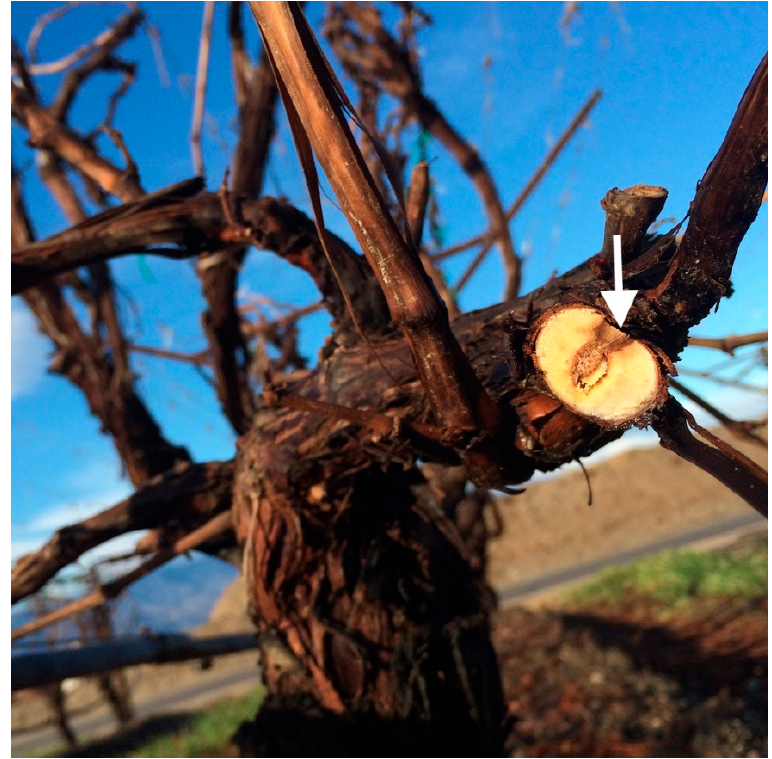
Figure 3. Trunk Diseases symptoms (white arrow) in the cordon of a grapevine.